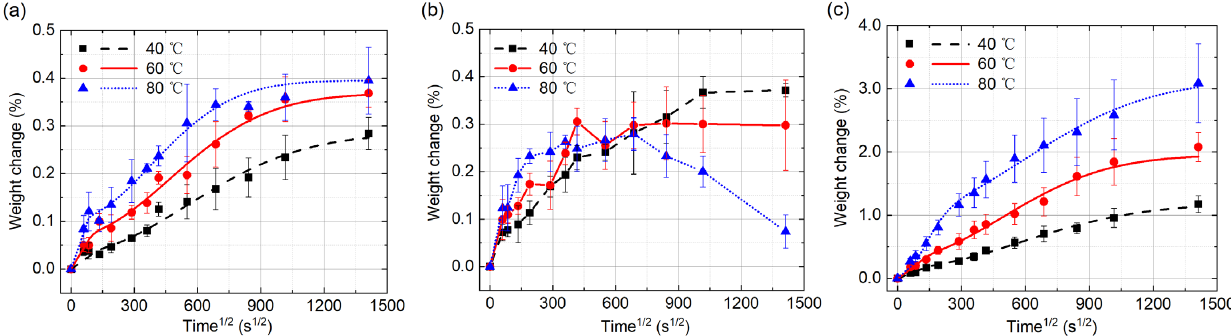
Figure 5. Weight changes of the samples in deionized water under different temperatures. ( a ) Type I; ( b ) Type II; ( c ) Type III. ( b ) Type II; ( c ) Type